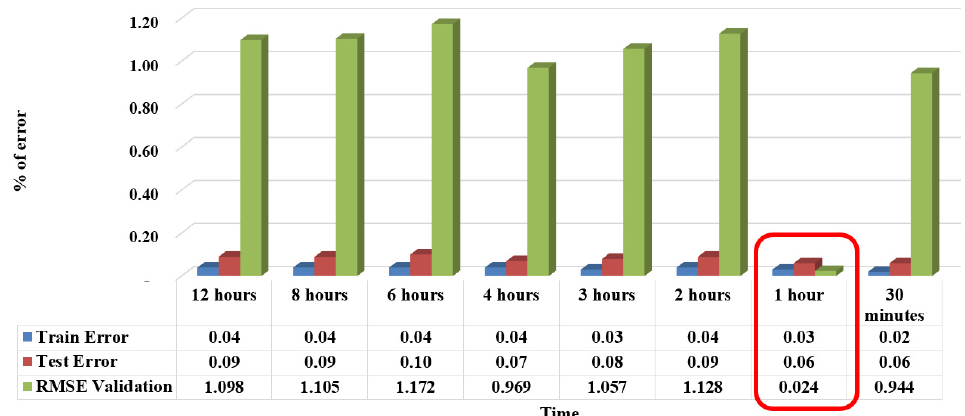
Figure 6. Comparison error results of the Soil Moisture value forecasting in different time intervals (LSTM model).